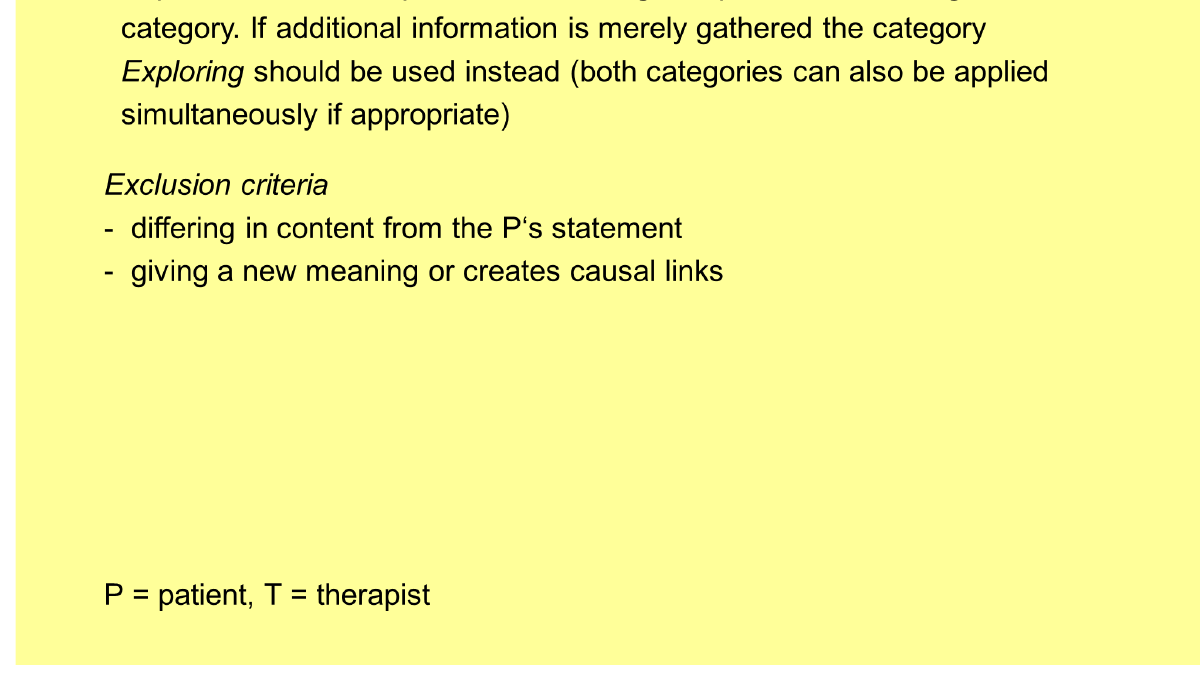
Fig 3. Definition of the category “Repeating, paraphrasing, summarizing”.